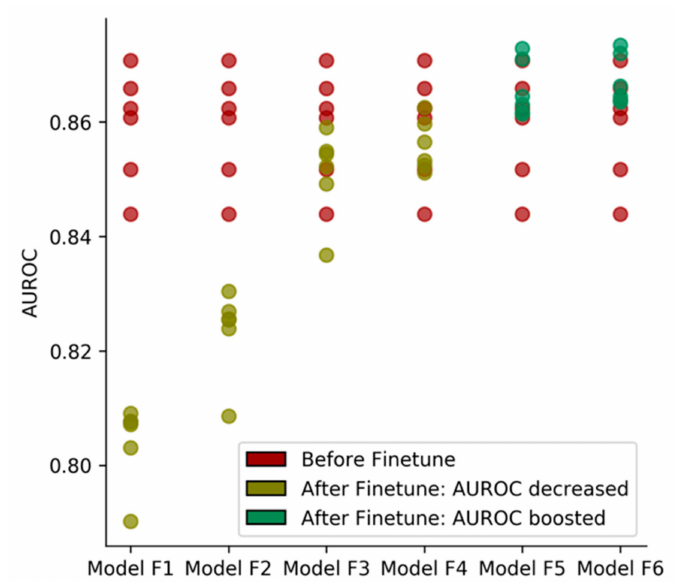
Figure 2. The effect of the use of different sets of transfer learning hyperparameters. Models F1– F6 correspond to the model finetuning with learning rate: 5 × 10 − 2 , batch size: 32; learning rate: 5 × 10 − 2 , batch size: 64; learning rate: 5 × 10 − 2 , batch size: 128; learning rate: 5 × 10 − 3 , batch size: 32; learning rate: 5 × 10 − 3 , batch size: 64; learning rate: 5 × 10 − 3 , batch size: 128.